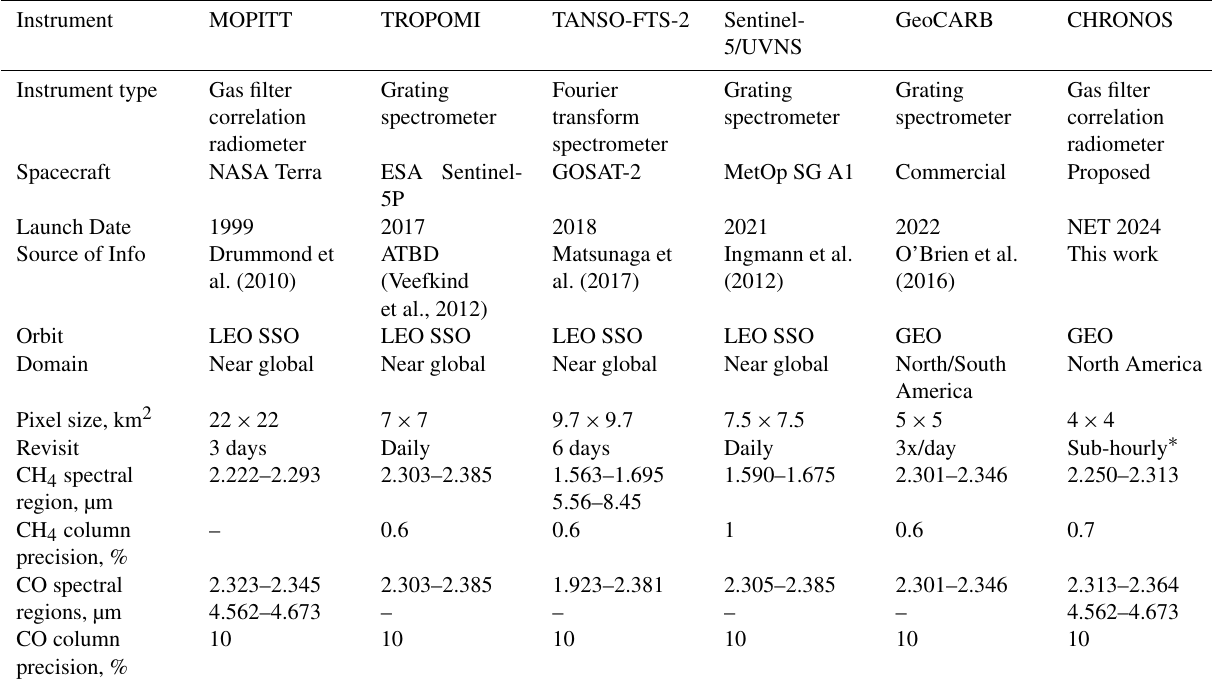
Table 3. Relationship of CHRONOS to current and future CO and CH 4 missions. CHRONOS contributes unique observations of multi- spectral CO for tracing air pollution transport and temporally dense CH 4 observations to improve emissions estimates across a continental